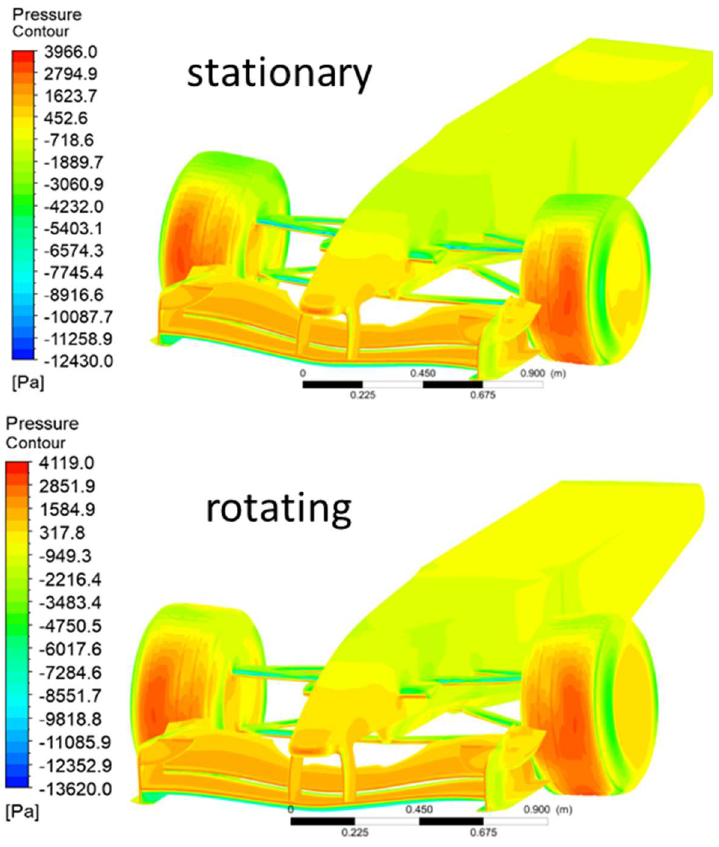
Figure 12. Pressure contours on 3D model with stationary wheel (upper) and rotating wheel (lower). With the front wing installed, the stagnation zone on the wheel is less extended than reduces drag and lift coefficients and slightly increases the pressure coefficient. In Figure